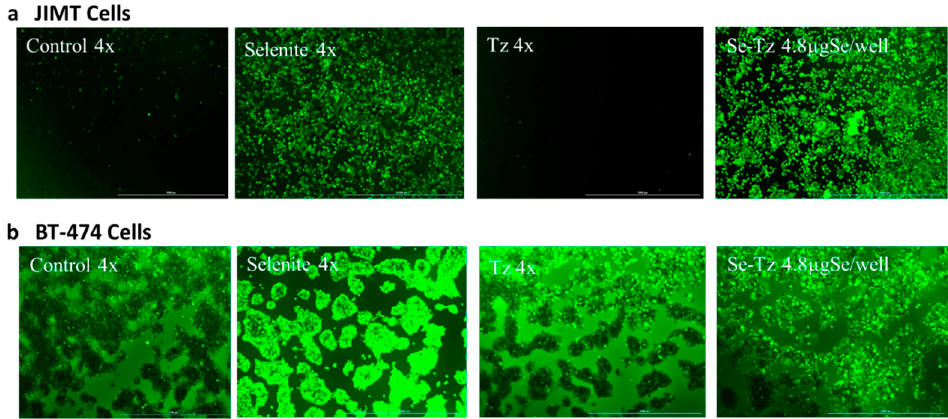
Figure 6. Photographic hydrogen peroxide detection by DCFH ‐ DA after selenium treatments at magnifications of 1000–1010 μ m. ( a ) Hydrogen peroxide staining of JIMT ‐ 1 cells after Se treatments; ( b ) hydrogen peroxide staining of BT-474 cells after Se treatments. After acclimatization for 24 h, 50 units/well of SOD and 100 units/well of catalase were added to all wells in media. All cells, control, selenite, Tz and Se-Tz were appropriately treated and then DCFH-DA was added to the cells at a final concentration of 30 µ M in media. Fluorescence intensity was read using a fluorescence microplate reader with an excitation at 475 nm and emission at 525 nm. Selenite was used as a redox toxic positive control at a concentration of 10 µ gSe/well. Selenite at concentrations less than 10 µ gSe/well had no visible effect on cancer cell lines under these experimental